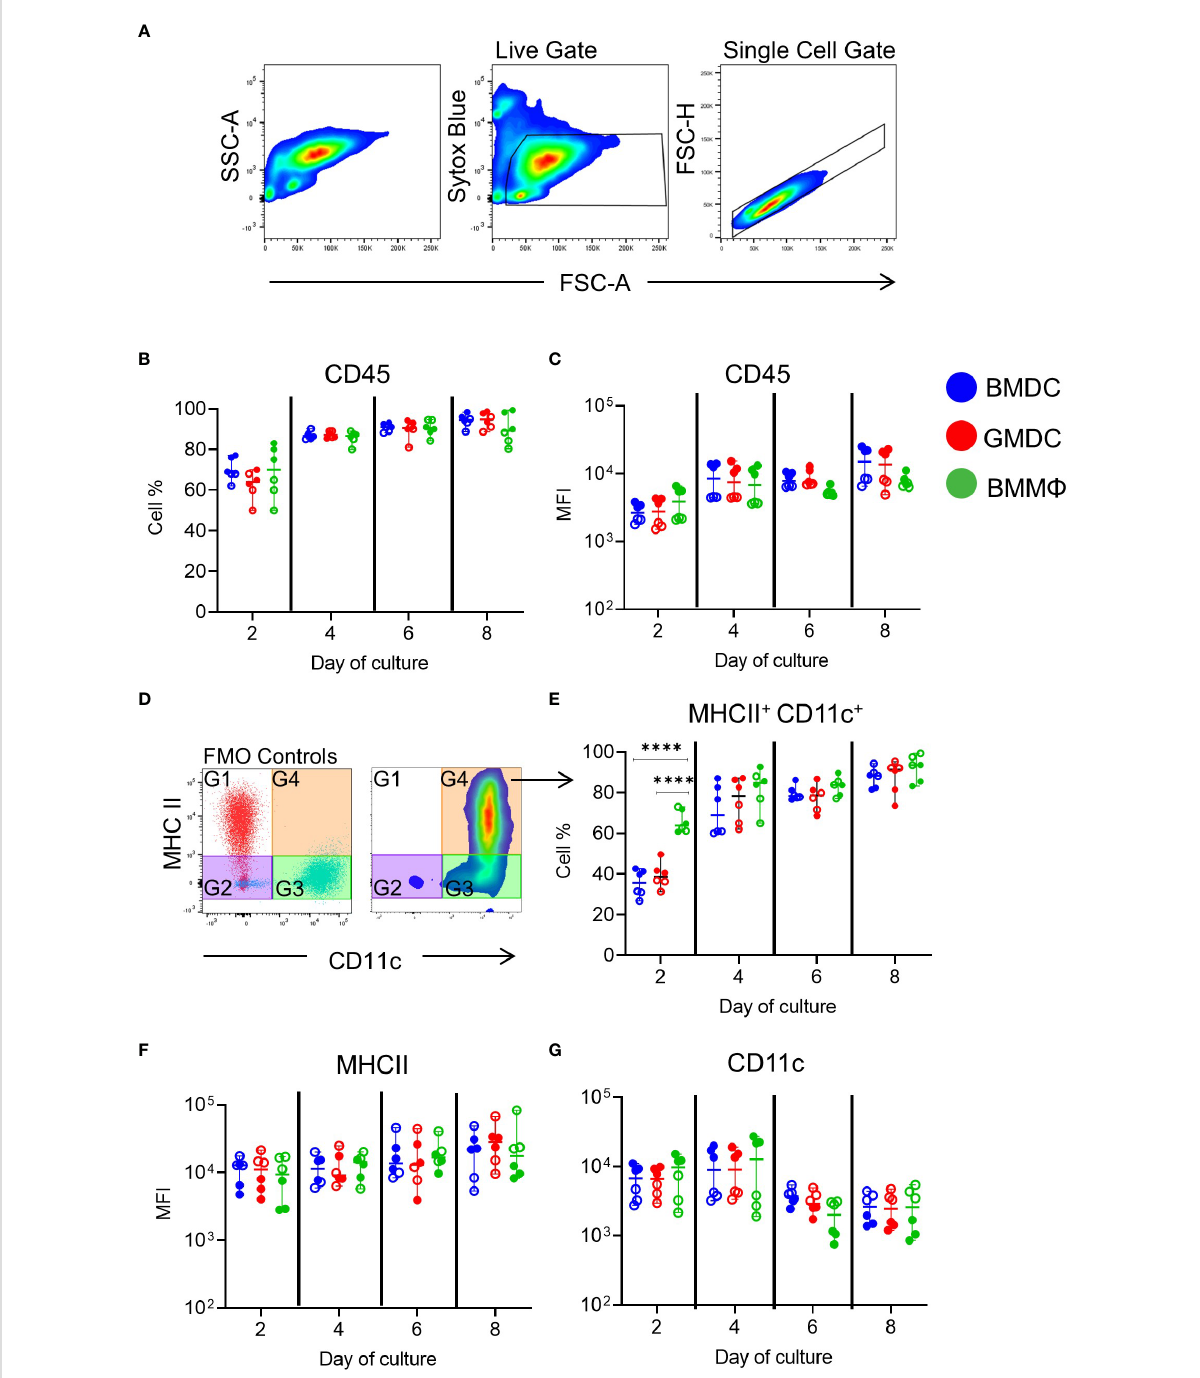
FIGURE 2 Phenotypic analysis of chicken BMDC, GMDC and BMM F on days 2, 4, 6 and 8 of culture. (A) Representative fl ow plots of SSC-A and FSC-A and live and single cell gating strategy applied to all cultures at each day of analysis. (B) The percentage of CD45 + cells and (C) median fl uorescence intensity (MFI) levels of CD45 expression live, single cells in BMDC (blue), GMDC (red) and BMM F (green) on days 2, 4, 6 and 8. (D) Dot plots representing FMO-1 control gating strategy on live, single cells for the analysis of MHCII + CD11c + (G3) cell percentages and (E) MFI of (F) MHCII and (G) CD11c expression levels in G4 across each culture on days 2, 4, 6 and 8. Data represents the median (± range). From each bird (n=6), BMDC, GMDC and BMM F were generated. Data represents two independent experiments (n=3 per experiment, open & closed circles). Statistical signi fi cant differences between cultures on day of analysis are indicated by